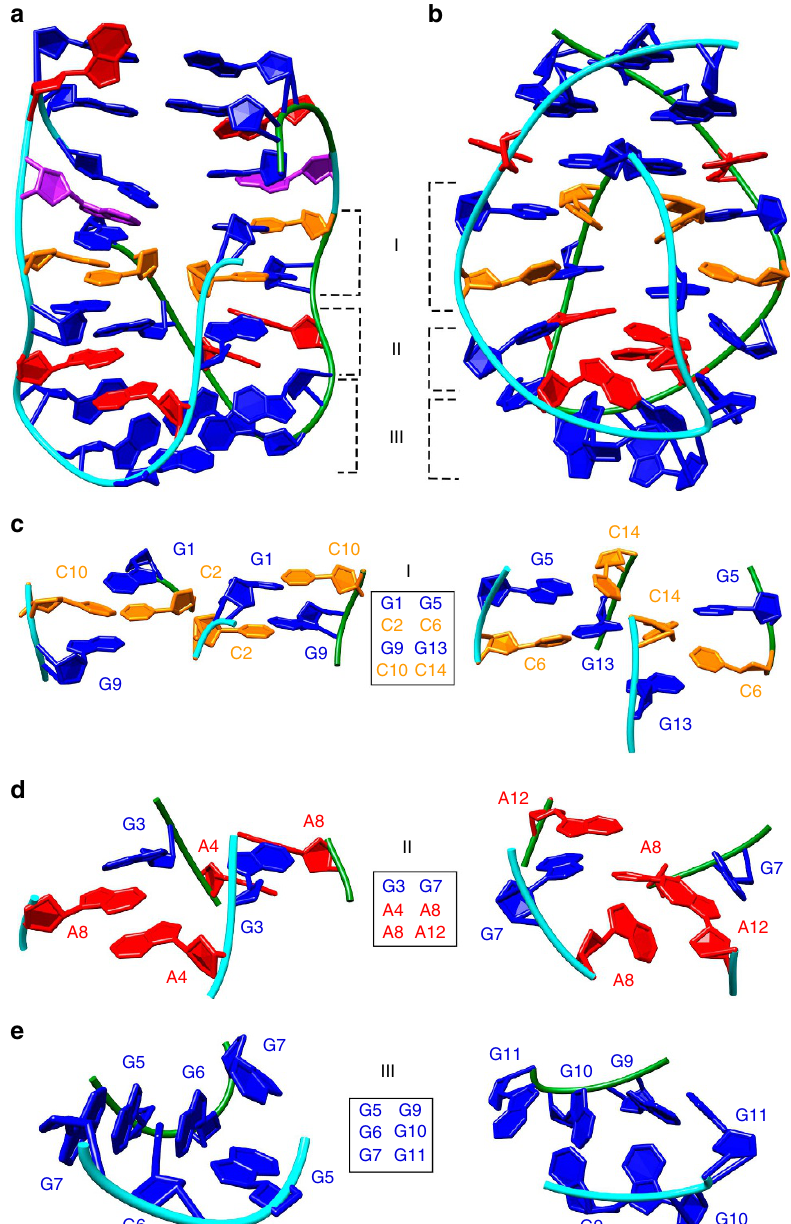
Figure 8 | Comparison of VK34_I11 and VK1 structures. ( a ) Overall representation of VK34_I11 structure. ( b ) VK1 structure. ( c ) Side views of G-C base pairs in VK34_I11 (left) and VK1 (right). ( d ) Insight into two G-A base pairs and the two A4 (left) and two A8 (right) residues orientated inside a hydrophobic pocket in VK34_I11 (left) and VK1 (right). ( e ) Side view of three G-G base pairs in fold-back arrangements in VK34_I11 (left) and VK1 (right). The roman numerals I, II and III refer to locations of the individual regions within the overall structure shown in a . The guanine residues are coloured blue, adenine red, cytosine orange and inosine purple. The two strands are coloured green and